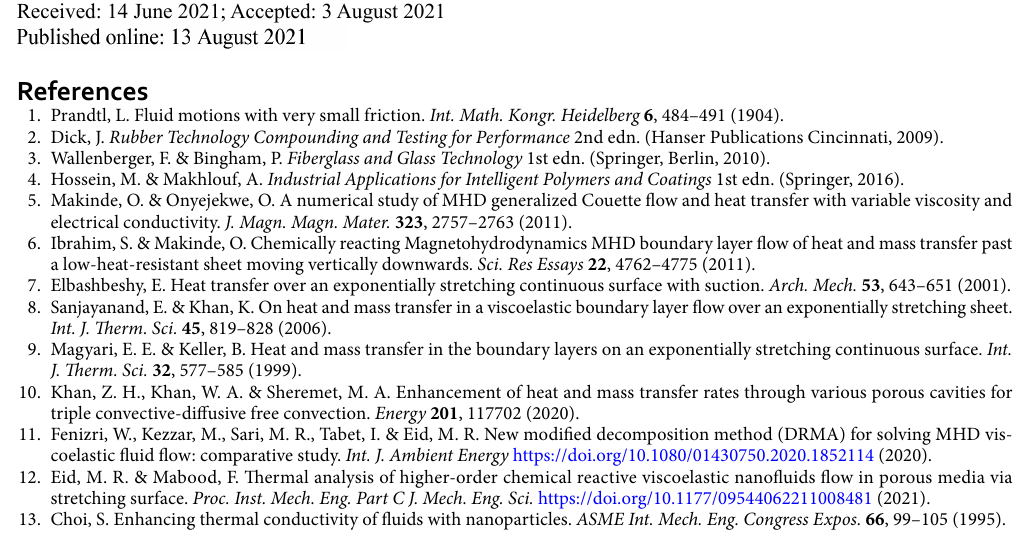
1 2 x and Nusselt number = Nu x Re